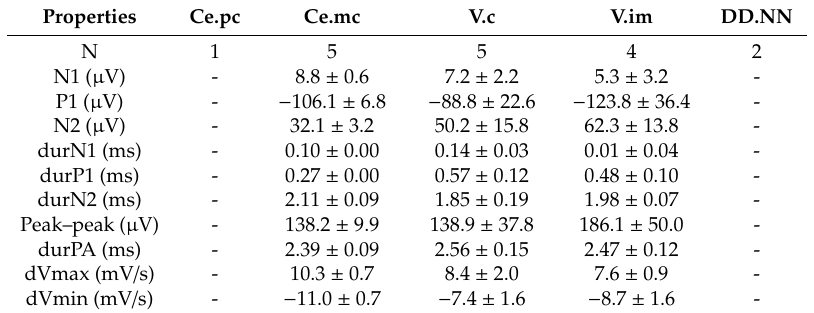
Table A4. Properties of mAP for P1N1P2. Values as x ± SEM , except of N , which indicates the number of mAP picked up from every nucleus.